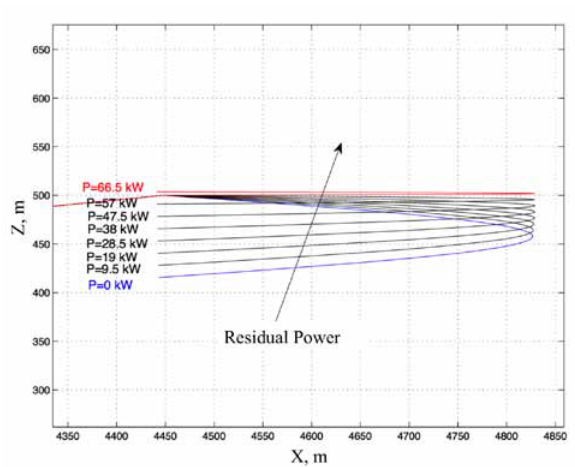
Fig. 14. Lateral view of different turns, at different residual power levels